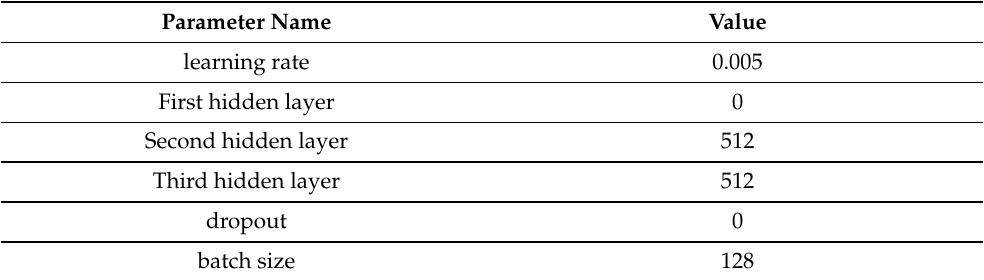
Table 4. Set of the hyperparameters for the Neural Network model with the best f1 score.